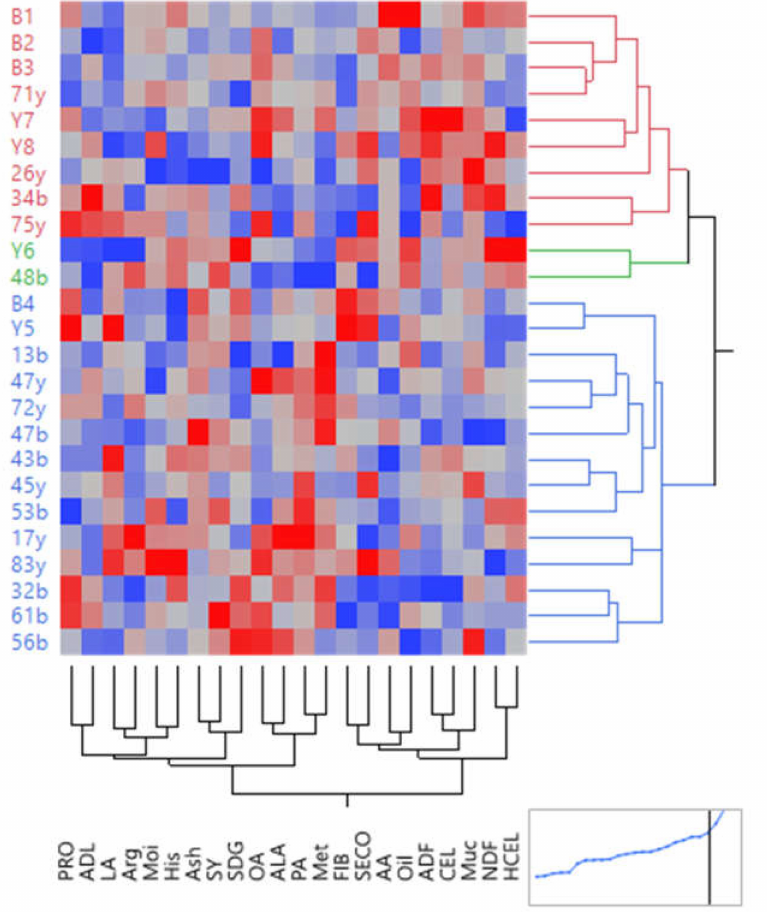
Figure 7. Heat mapping diagram related to the studied traits of flax families under water stress conditions. The dark blue color indicates the lowest value of the characters, and the dark red color indicates the highest value. SY: seed yield. Oil: oil content. NDF: neutral detergent fibers.